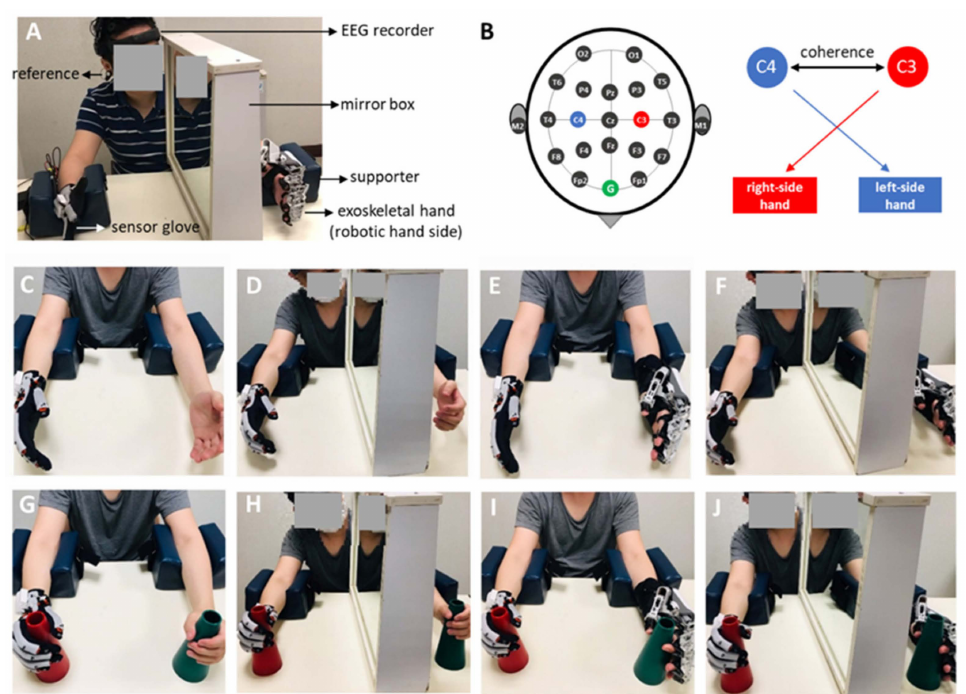
Figure 2. The experimental setup, analyzed electrodes, and the eight experimental conditions. ( A ) The experimental setup using the dry-electrode-based EEG recorder when the exoskeleton robot was applied on the participant. ( B ) The 10–20 EEG map, among which the coherence between C3 and C4 electrodes was analyzed, by assuming the right and left heads were controlled by the motor cortexes overlying the C3 and C4 electrodes, respectively. ( C – J ) The eight experimental conditions (using a factorial design of 2 object manipulation × 2 robot therapy × 2 mirror therapy conditions), including the unilateral hand movement without applying robot, mirror and object ( C ), conventional mirror therapy ( D ), robot-assisted bimanual training ( E ); robot-assisted mirror therapy ( F ); ( G – J ) were the trainings of ( C – F ) with object